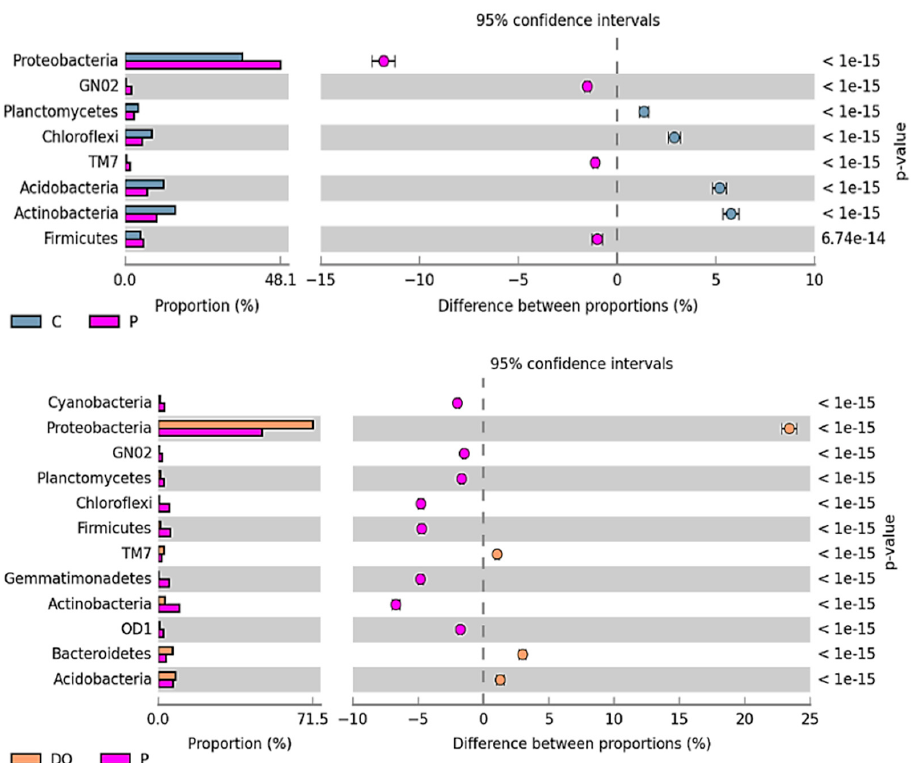
Figure 2. The relative abundance of dominant phylum of bacteria in the soil with the difference between proportions ≥ 1%. C—uncontaminated soil, DO—soil contaminated with diesel oil, P—soil contaminated with unleaded petroleum.